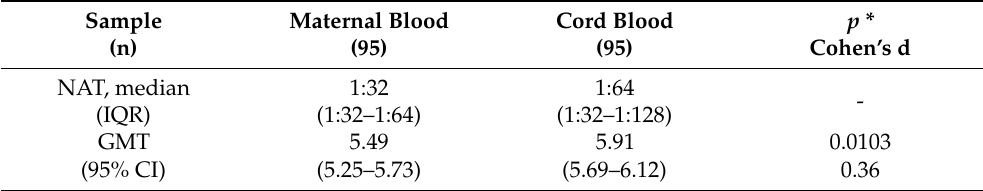
Table 3. NATs against RSV type A in maternal and cord blood.